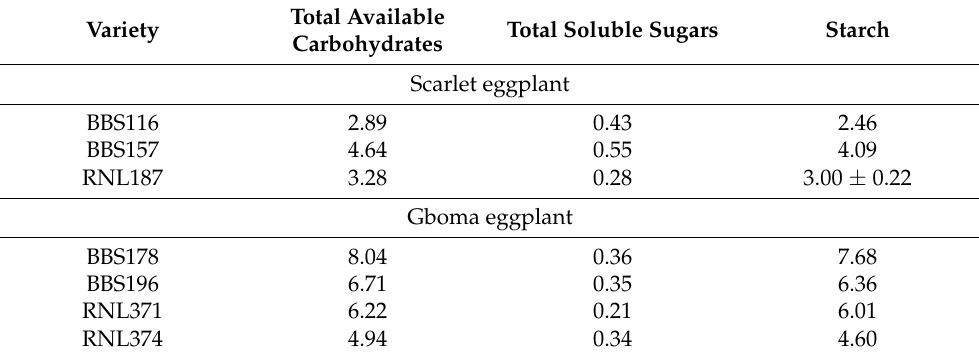
Table 6. Carbohydrate content in scarlet and gboma eggplant varieties (g/100 g)